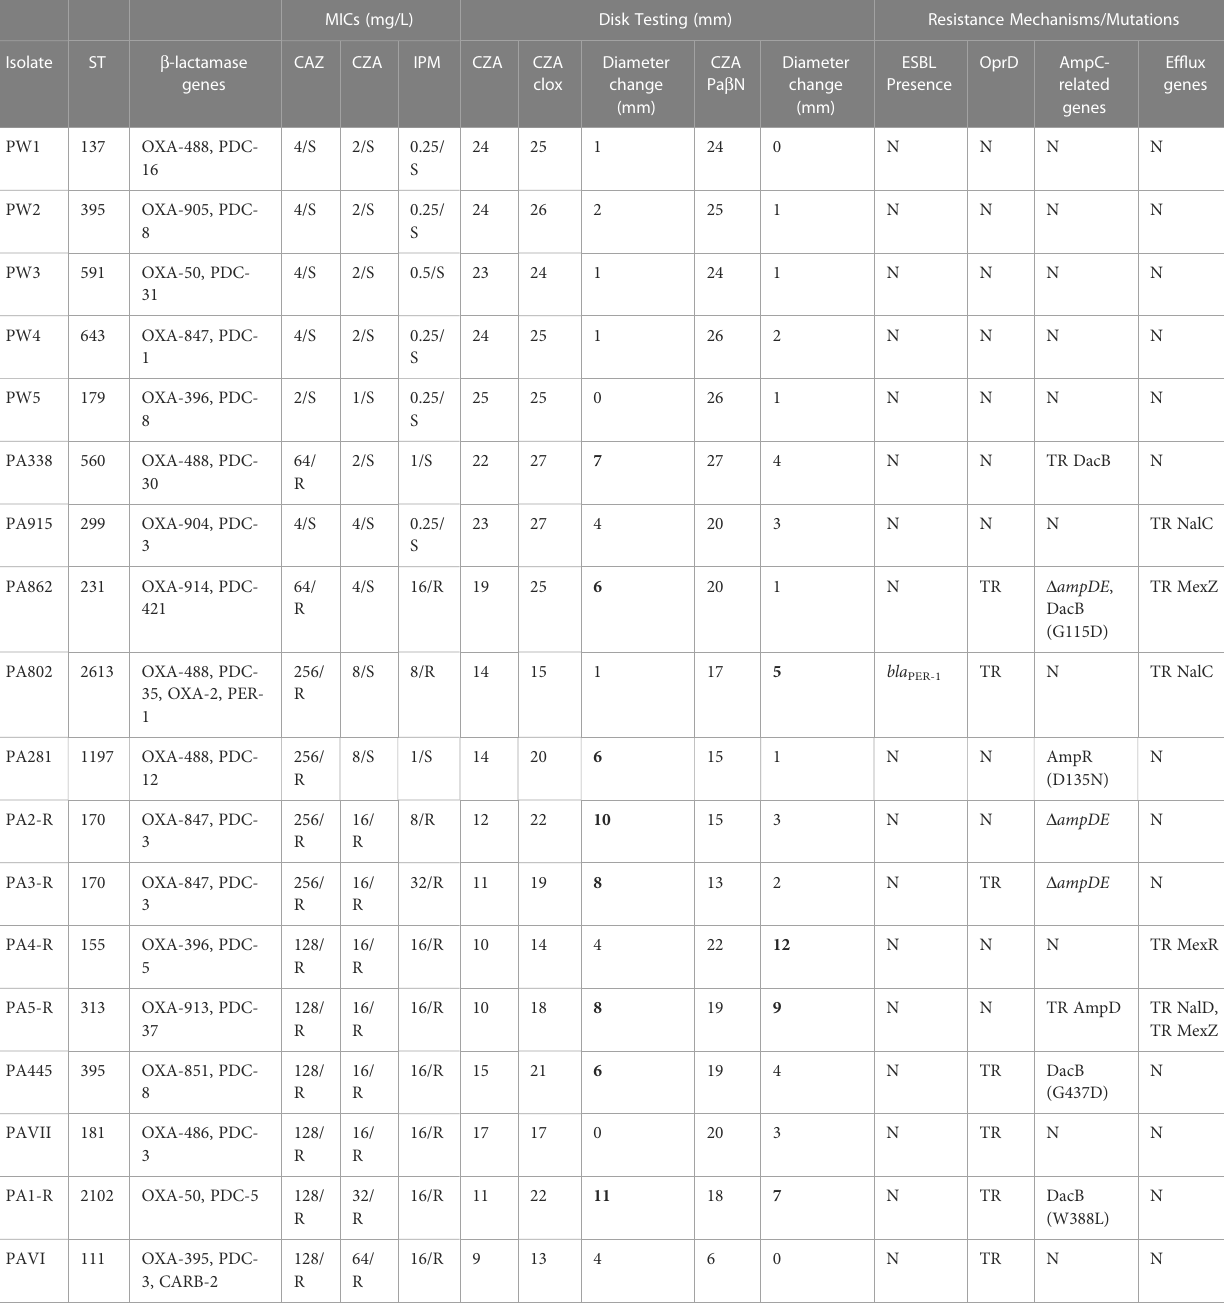
TABLE 1 Characteristics of the isolates in this study as identi fi ed by susceptibility testing and whole genome